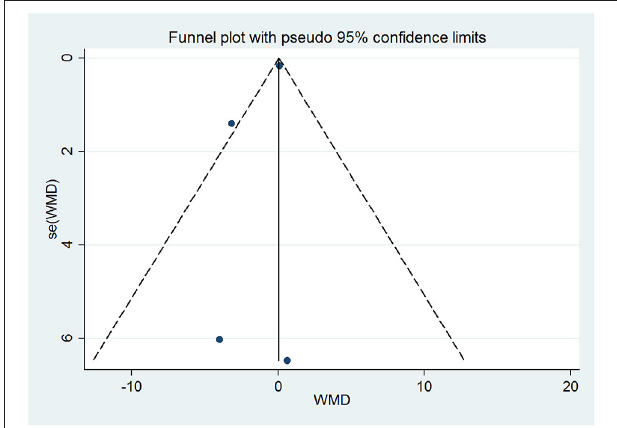
FIGURE 5 | Funnel plot for publication bias test of total cholesterol. Each point represents a separate study for the indicated association.